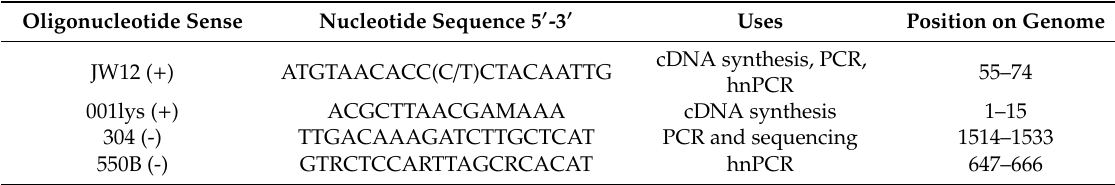
Table 1. The Oligonucleotide primer sequences used in the study showing the annealing positions and their nucleotide sequences